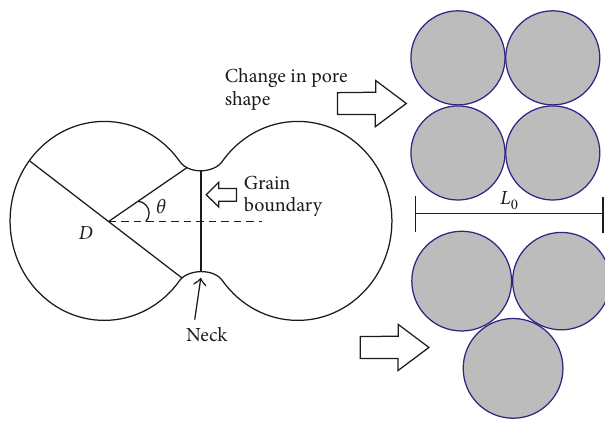
Figure 4: Mechanism of the sintering process. Necking stage formation between particles and their growth and porosity dis- tribution. D is the particle diameter, θ is the diffusion angle, and L 0 is the initial distance of particles.